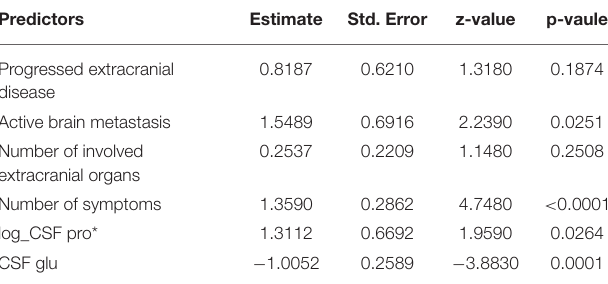
TABLE 4 | Coefficients of predictors in model